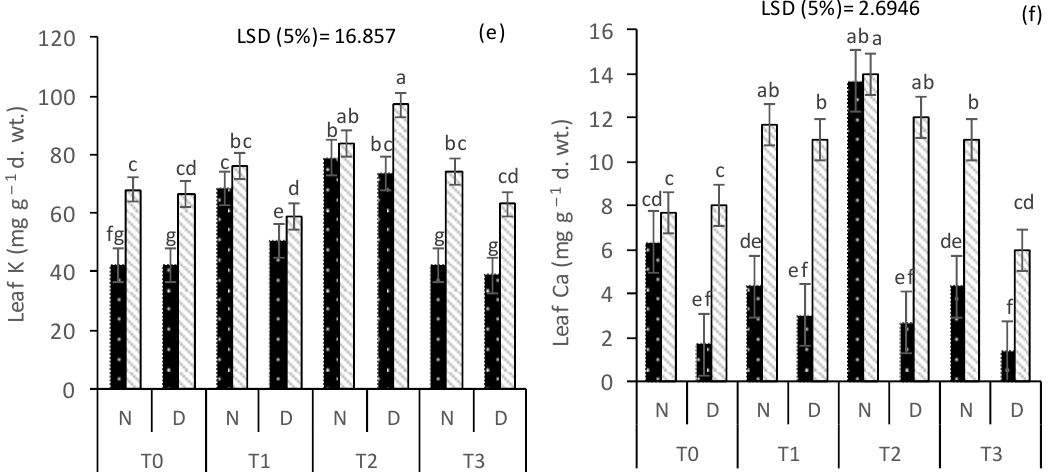
Figure 6. Effects of laser seed priming on ( a ) total soluble proteins, ( b ) total soluble sugars, ( c ) total free amino acids, ( d ) leaf sodium ion, ( e ) leaf potassium ion and ( f ) leaf calcium ion in wheat under drought stress . Legend: N = Control (100% field capacity), D = Drought (50% field capacity), T0 = Unprimed control, T1 = 1 min laser priming, T2 = 2 min laser priming and T3 = 5 min laser priming. Means sharing same lowercase letters on bars are statistically non−significant at P ≤ 0.05%)